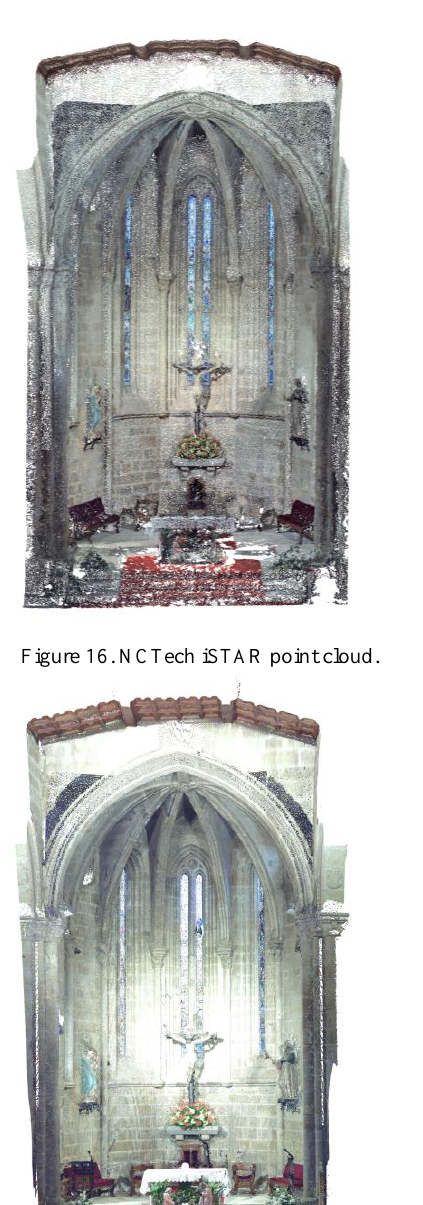
Figure 14. Canon 550 D SRL point cloud. Figure 15. Canon 550 D SRL textured mesh.